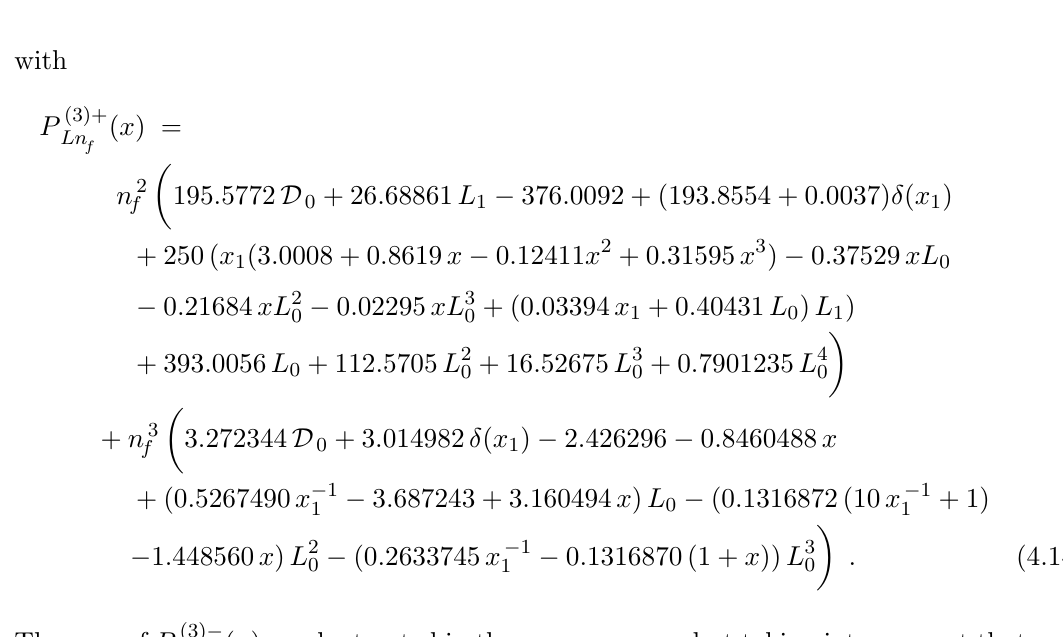
Figure 6 . As (cid:12)gure 5, but for the n 1 smaller x -range than in (cid:12)gure 5 due to a sign change of the function at x width of the uncertainty band close to x = 1 is due to another change of sign at (1